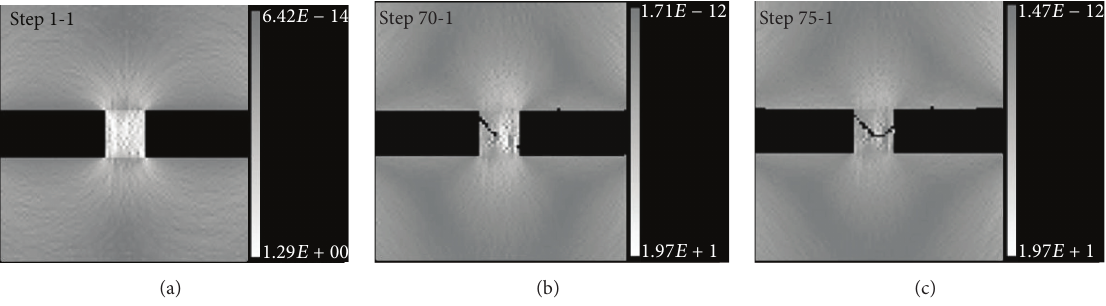
Figure 9: Plot of shear stresses around a pillar with width-to-height ratio = 1.0.